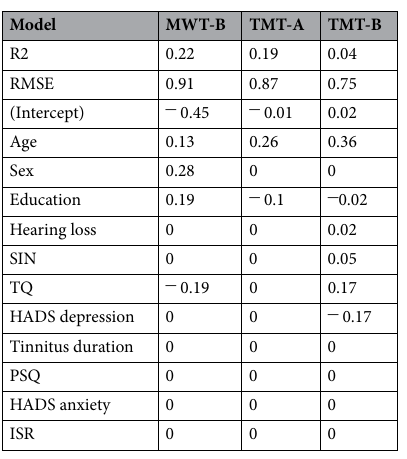
Table 2. Model parameters and coefficients of the 3 models. Coefficients are visualized in Fig. 1. RMSE = root-mean-square